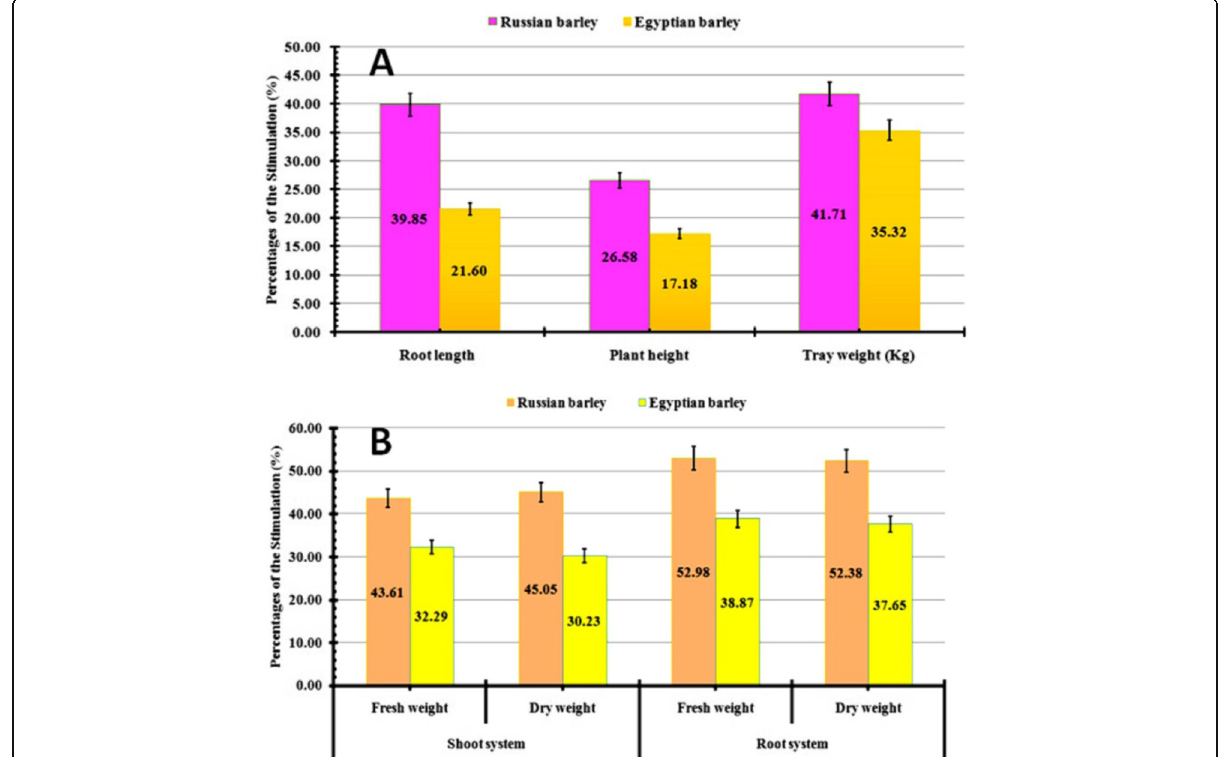
Fig. 6 Physiological parameters of the sprouting barley plant that treated with endophytic T. harzianum through hydroponic system, ( A ): Root length, plant height, tray weight; ( B ): Shoot system, and root system